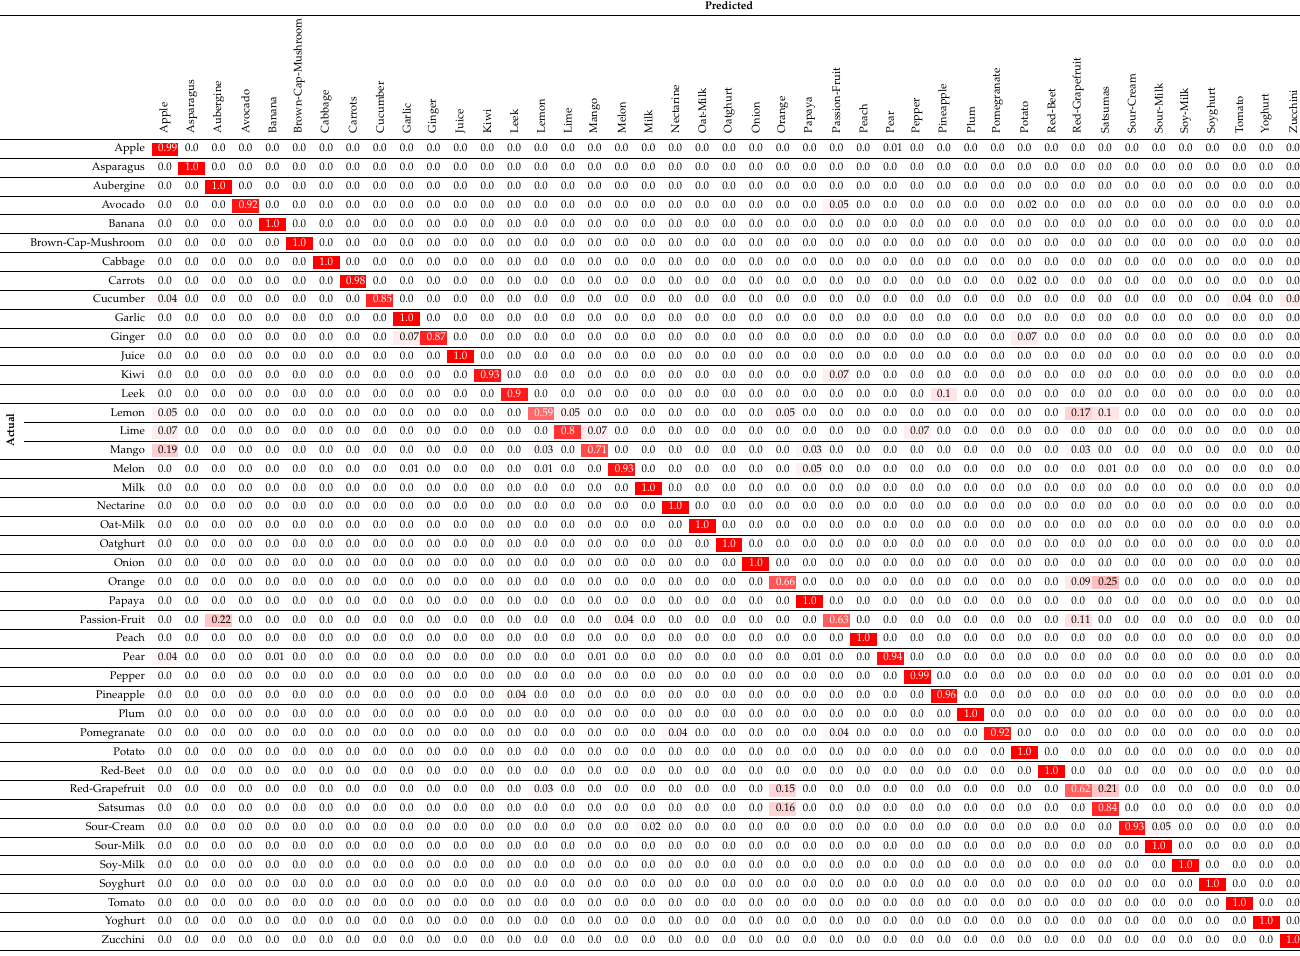
Table 3. Confusion Matrix of the tiered ResNeXt-101 model (with 20%